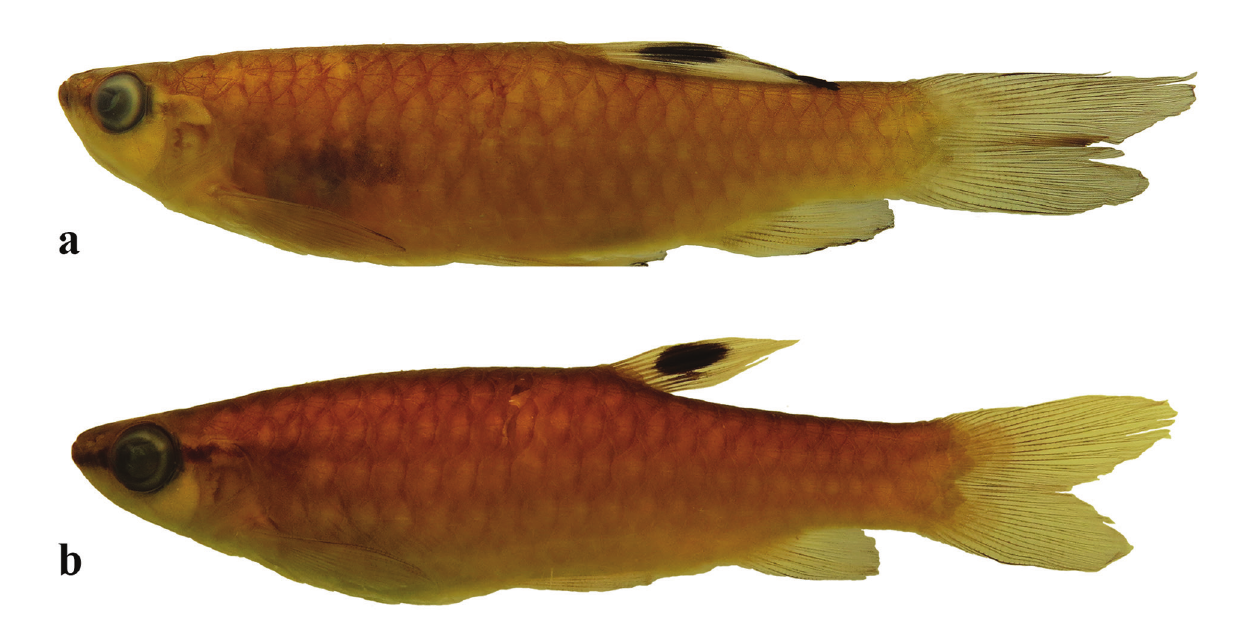
Fig. 1. Lateral view of Pyrrhulina capim , new species, rio São José, Bragança, Pará, Brazil. a. holotype, UFRGS 27300, 54.4 mm SL, male; b. paratype, UFRGS 25562, 40.4 mm SL,